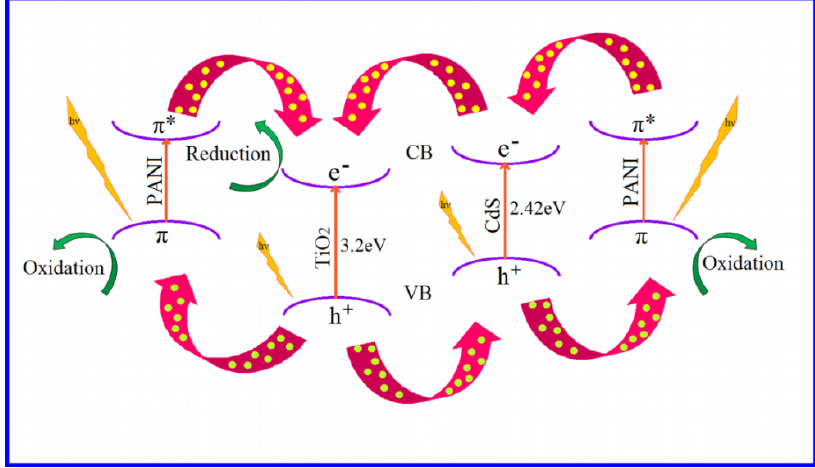
ically in Figure 13.